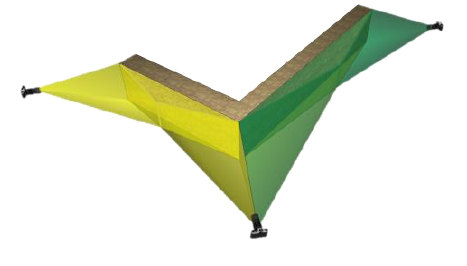
Figure 5. Scheme illustrating camera positions for overall photos